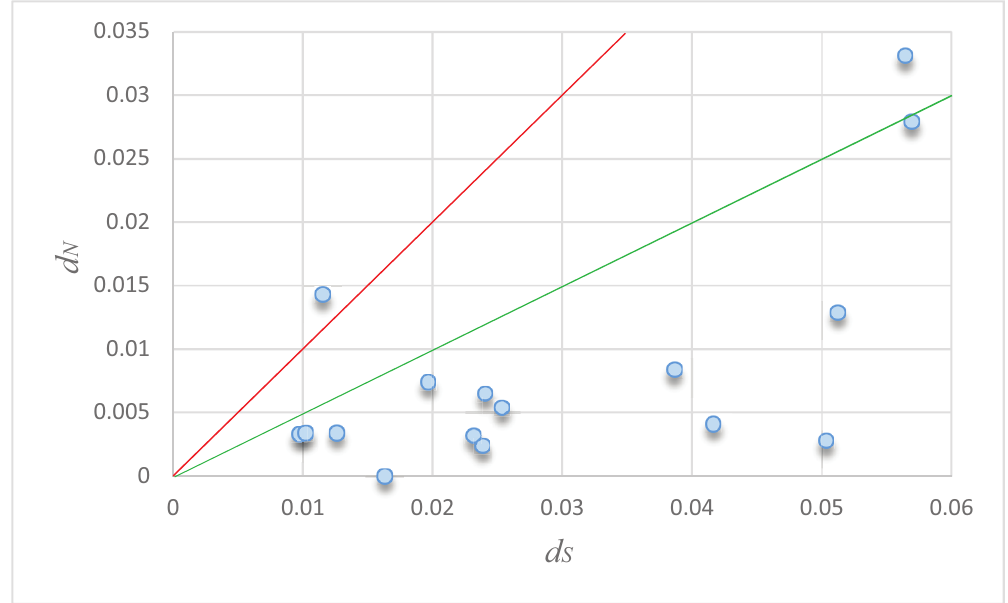
Figure 5. Distribution of d N and d S for 16 pairs of the putative 4CL orthologs between P . pruinosa and P . euphratica . The orthologs with d N / d S > 1 fall above the red line while those with d N / d S = 0.5–1 fall between the green and red lines. The name and the value ( d N / d S ) of 16 pairs of genes were listed in the Table